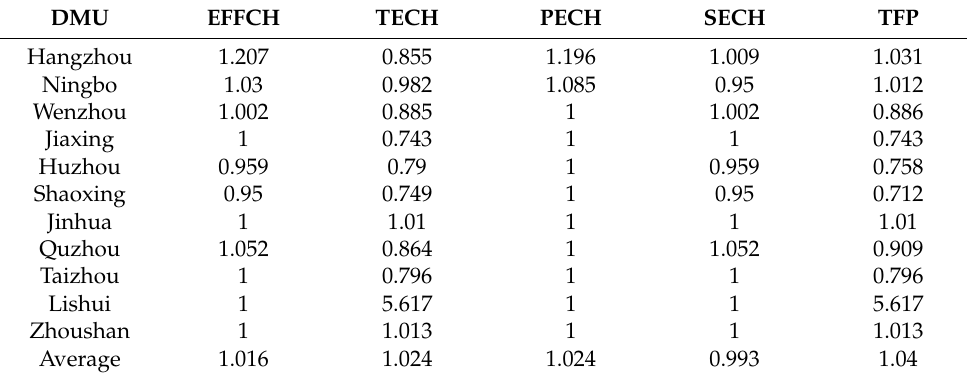
Table 6. Overall change index and decomposition index of value-conversion efficiency of ecological products in cities of Zhejiang Province from 2001 to 2020.